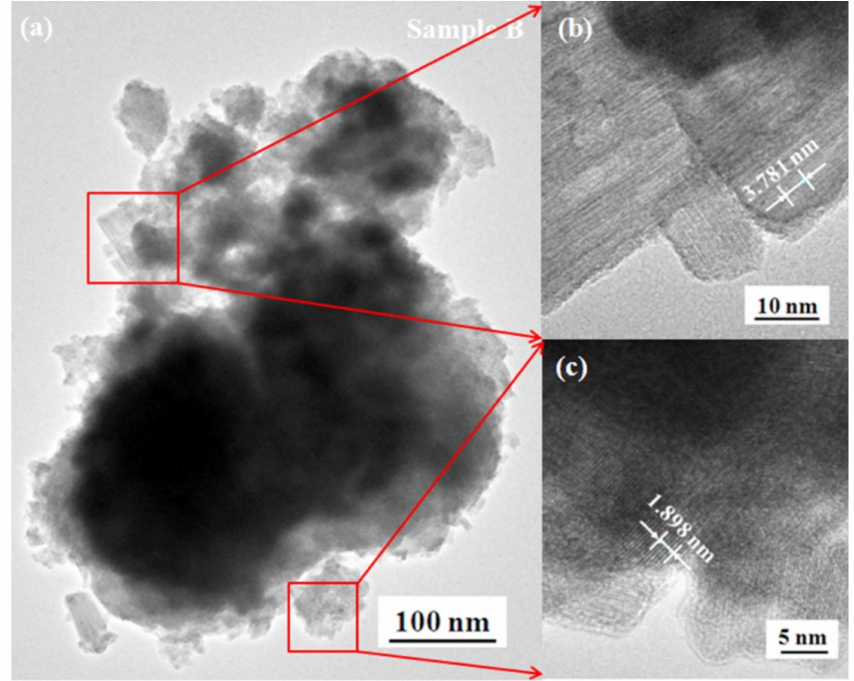
Figure 7. TEM images of sample B. The image ( a ) indicates that sample B is the submicro-spherical- like structure mixed some nanorods and the submicro-spherical-like structure is aggregated by nanoparticles. The high-resolution TEM images indicate that the nanorod ( b ) and nanoparticle ( c ) are the crystalline structure with the lattice spacing of ~0.378 and 0.380 nm, respectively.